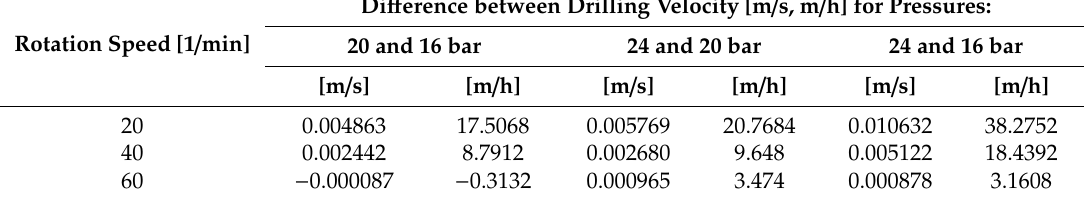
Table 1. Di ff erences between drilling velocity measured for various air pressures and drill rotation speeds of the 110 mm diameter drill bit, in the interval 54–72 m below ground level. Di ff erence between Drilling Velocity [m / s, m / h] for Rotation Speed [1 / min]